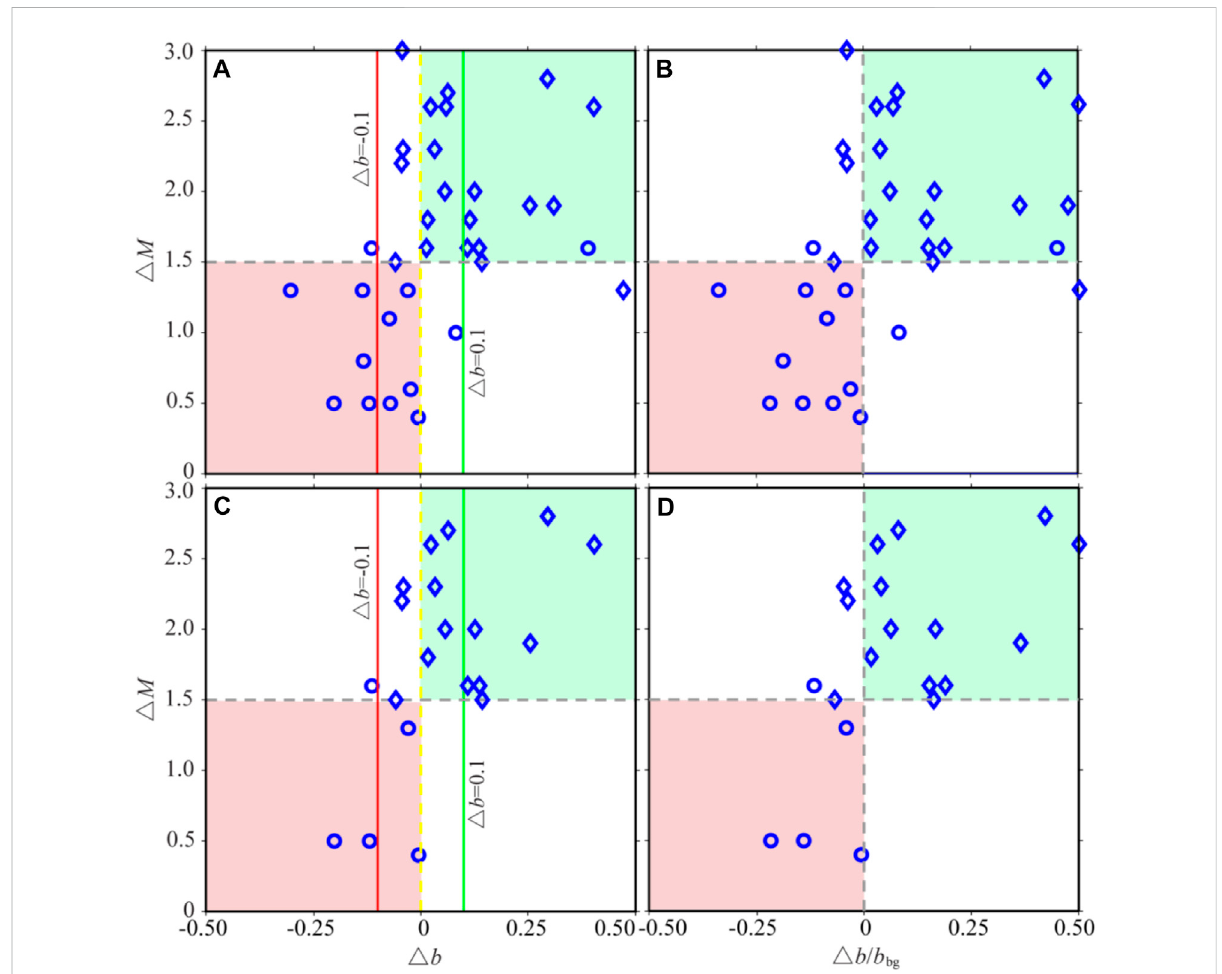
FIGURE 6 Relationship between magnitude difference and sequence parameters. (A) Relationship between △ M and △ b ( △ b = b after - b bg ) (1970.01.01 – 2020.07.30); (B) relationshipbetween △ M and △ b / b bg (1970.01.01 – 2020.07.30); (C) relationshipbetween △ M and △ b ofthesequences after 12 May 2008; (D) relationship between △ M and △ b / b bg of the sequences after 12 May 2008. The circle represents the earthquake sequence having strong aftershocks with M ≥ 5.0, and the diamond represents the earthquake sequence having no strong aftershocks with M ≥ 5.0 in the fi tting period. The red, yellow, and green lines indicate △ b = 0.1, △ b = 0 and △ b = -0.1, respectively. The green area represents △ M > 1.5 and △ b > 0, while the red area represents △ M < 1.5 and △ b <